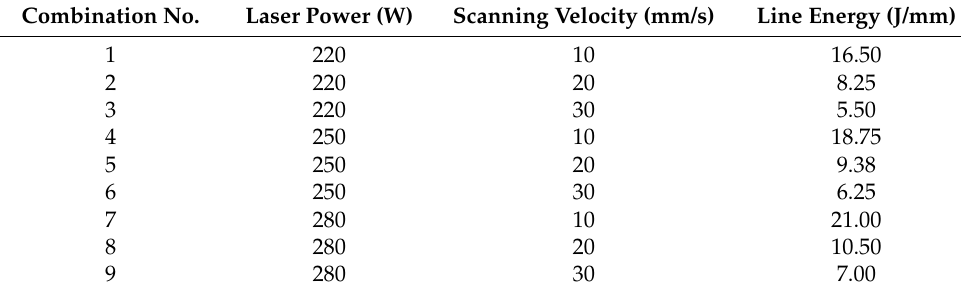
Table 1. Combinations of laser parameters for the experiment.